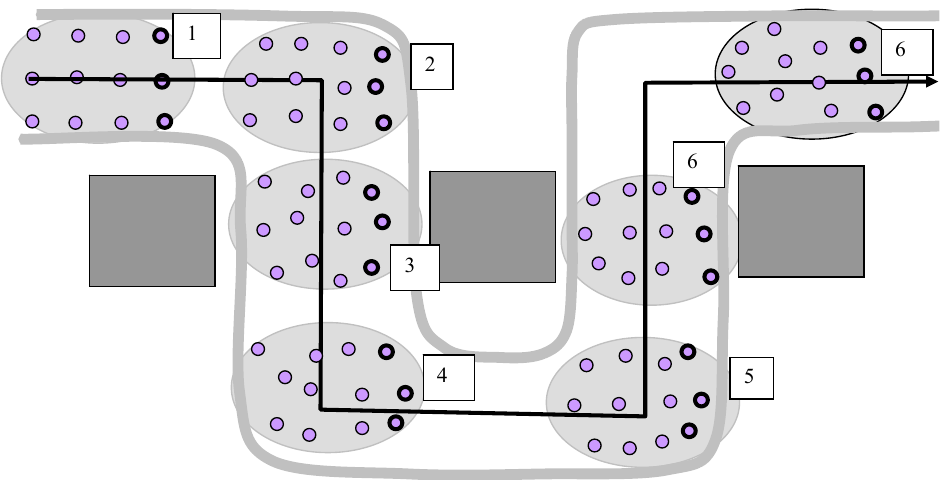
Figure 22. The track of the swarm guided by an operator in test 5 for a nonhierarchical structure. The sequences of swarm position are marked with numbers.